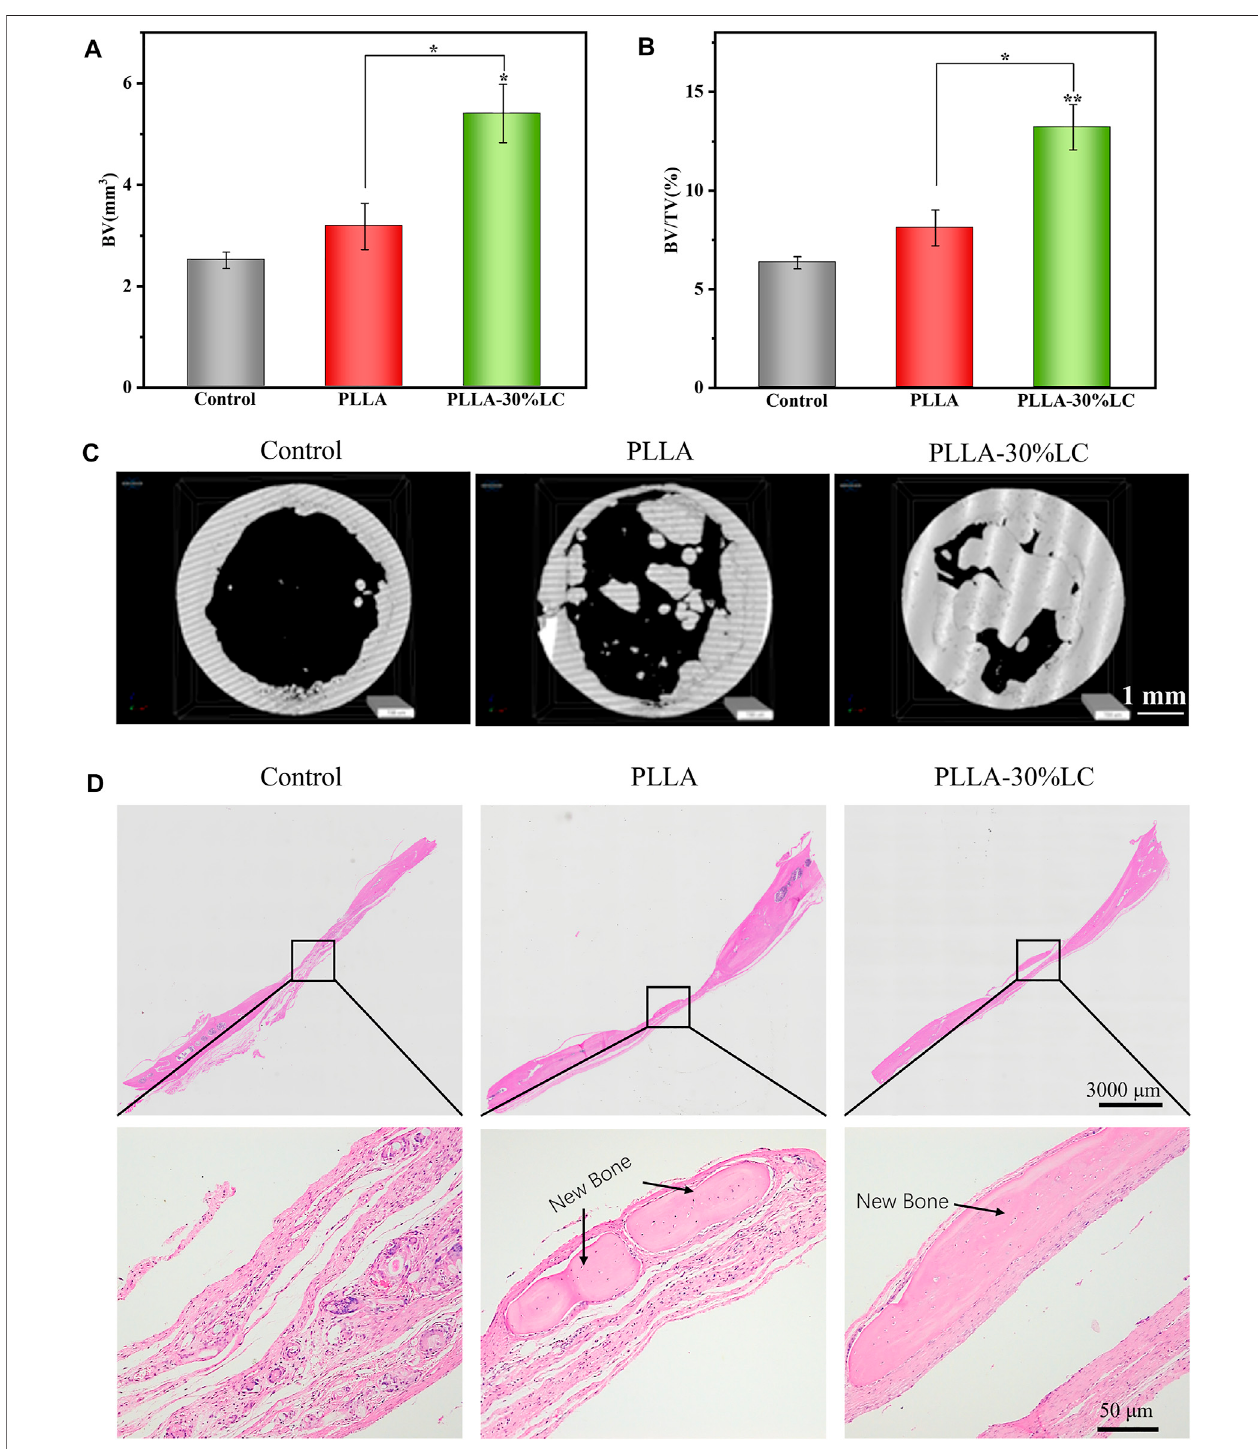
FIGURE7| (A) Bone volume analysis; (B) bone volume density analysis; (C) micro-CTimage ofan SD ratskull defect 4 weeksafter operation; and (D) HE staining photograph of an SD rat skull defect.